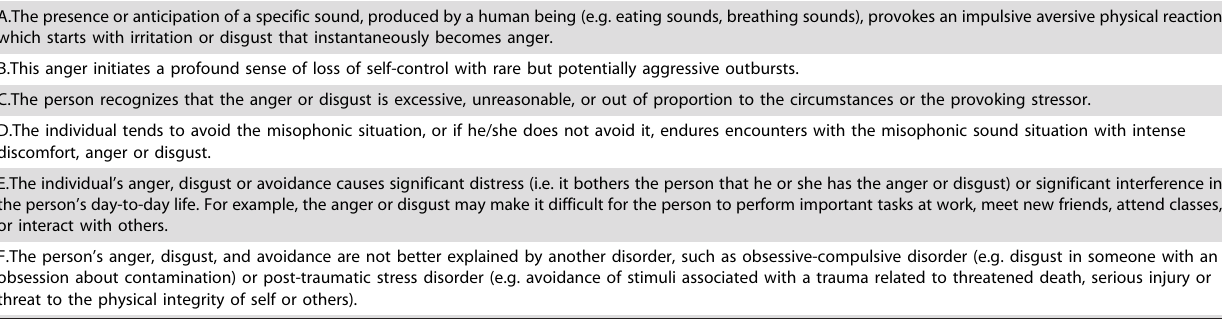
Table 2. Proposed diagnostic criteria for